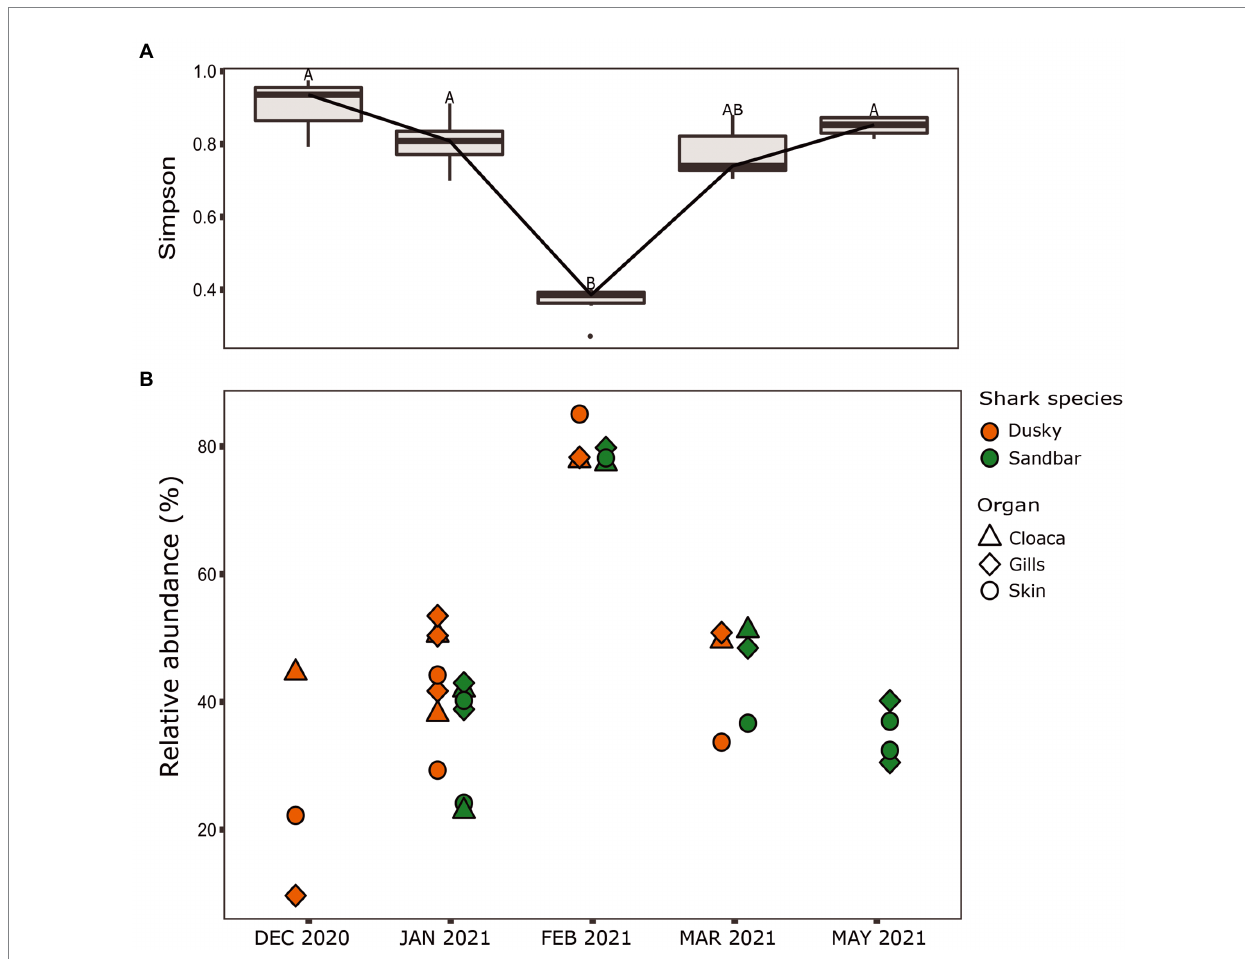
FIGURE 7 Season 2021. (A) Simpson diversity index of sharks’ samples. The letters A/B above the boxes represents a significant difference between the samples. (B) Relative abundance of Streptococcus sp. isolated from the shark